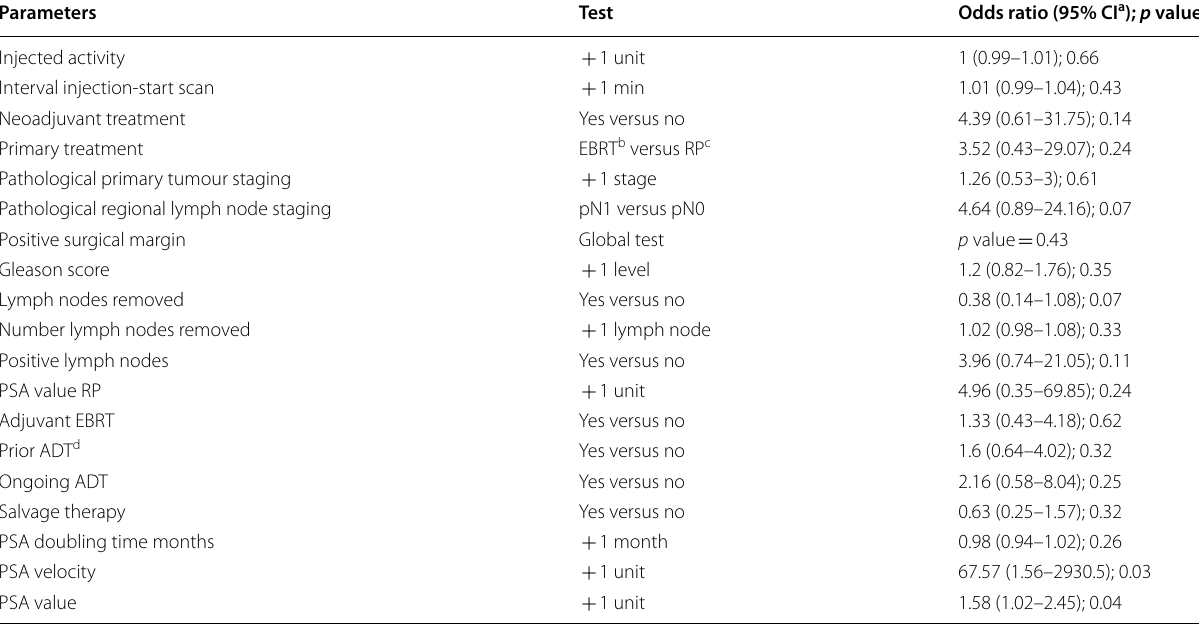
a Confidence interval b External beam radiation